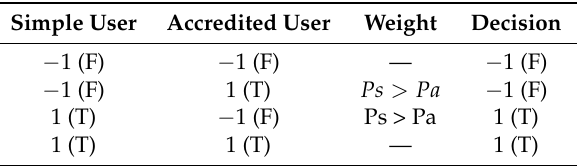
Table 4. Decision-making P s > P a